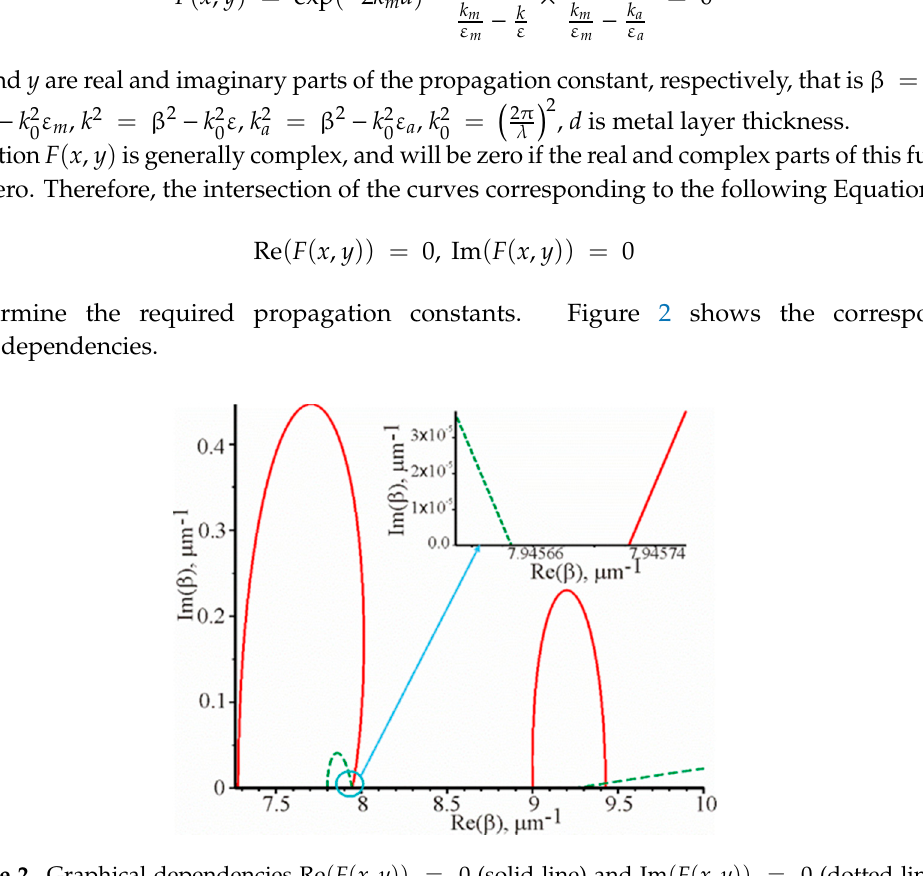
Figure 2. Graphical dependencies Re ( F ( x , y )) = 0 (solid line) and Im ( F ( x , y )) = 0 (dotted line) at the following parameters of the prism structure: λ = 1.064 µ m , θ = 1.040226 rad, d = 52.55 nm, ε m = − 57.1915 + i 1.26097 [16,20], n = 1.56 and n a = 1.3242. The reflection coe ffi cient from the metal film is 0.000041 at these parameters. The insertion shows solid and dotted curves on a larger scale.